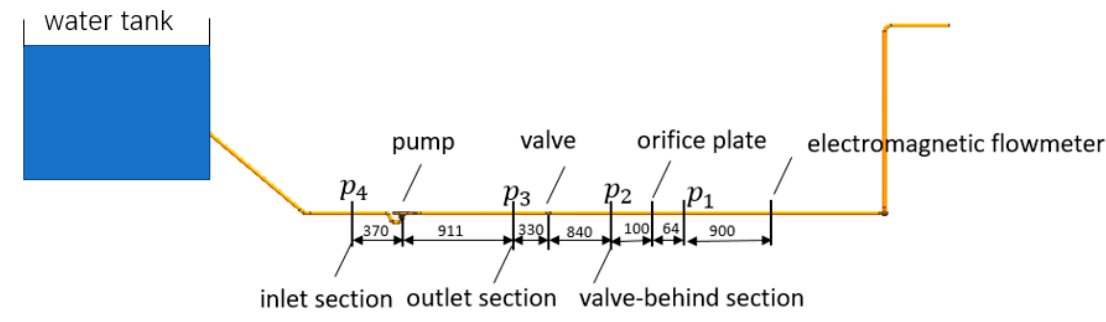
Figure 2. Diagram of the experiment (units are mm) .